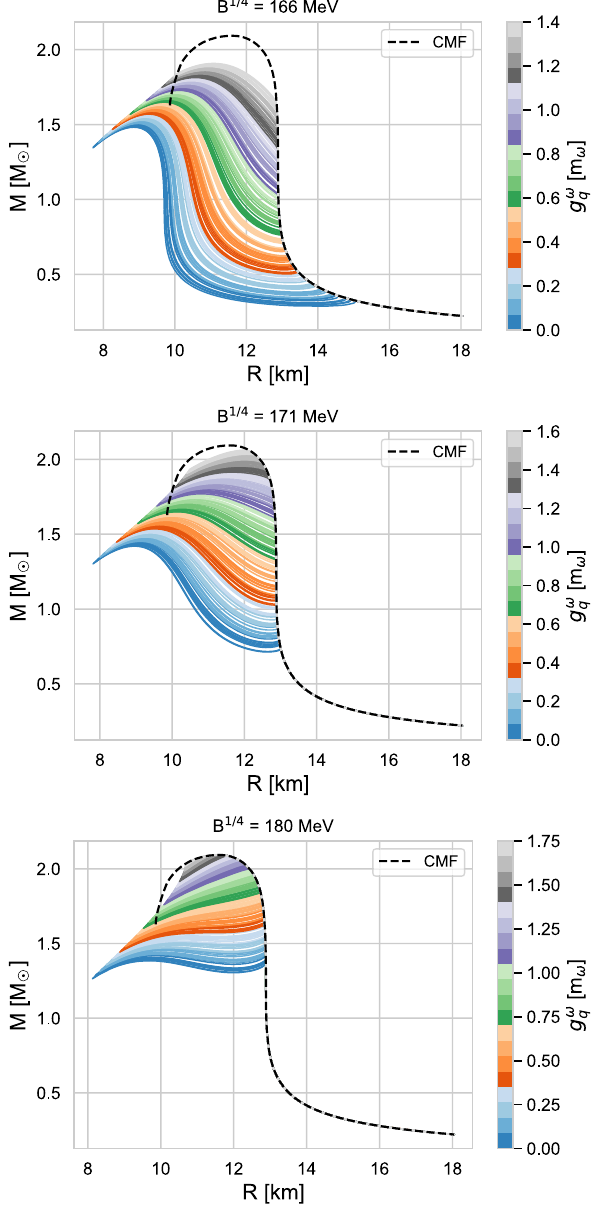
Fig. 7 M–R relation for three different Bag constants B 1 / 4 ∈ { 166 , 171 , 180 } MeV with corresponding EoS in Fig. 6. The colorbar in each row shows different quark couplings ranging from small val- ues (blue) to high values (grey). The black star M max is the maximum mass of the pure CMF curve and the blue horizontal line is the two flavor Stefan–Boltzmann limit. Smaller values for B shift the transition to smaller masses, this behaviour was also observed for both 2- and 3-flavor MIT Bag-CMF models